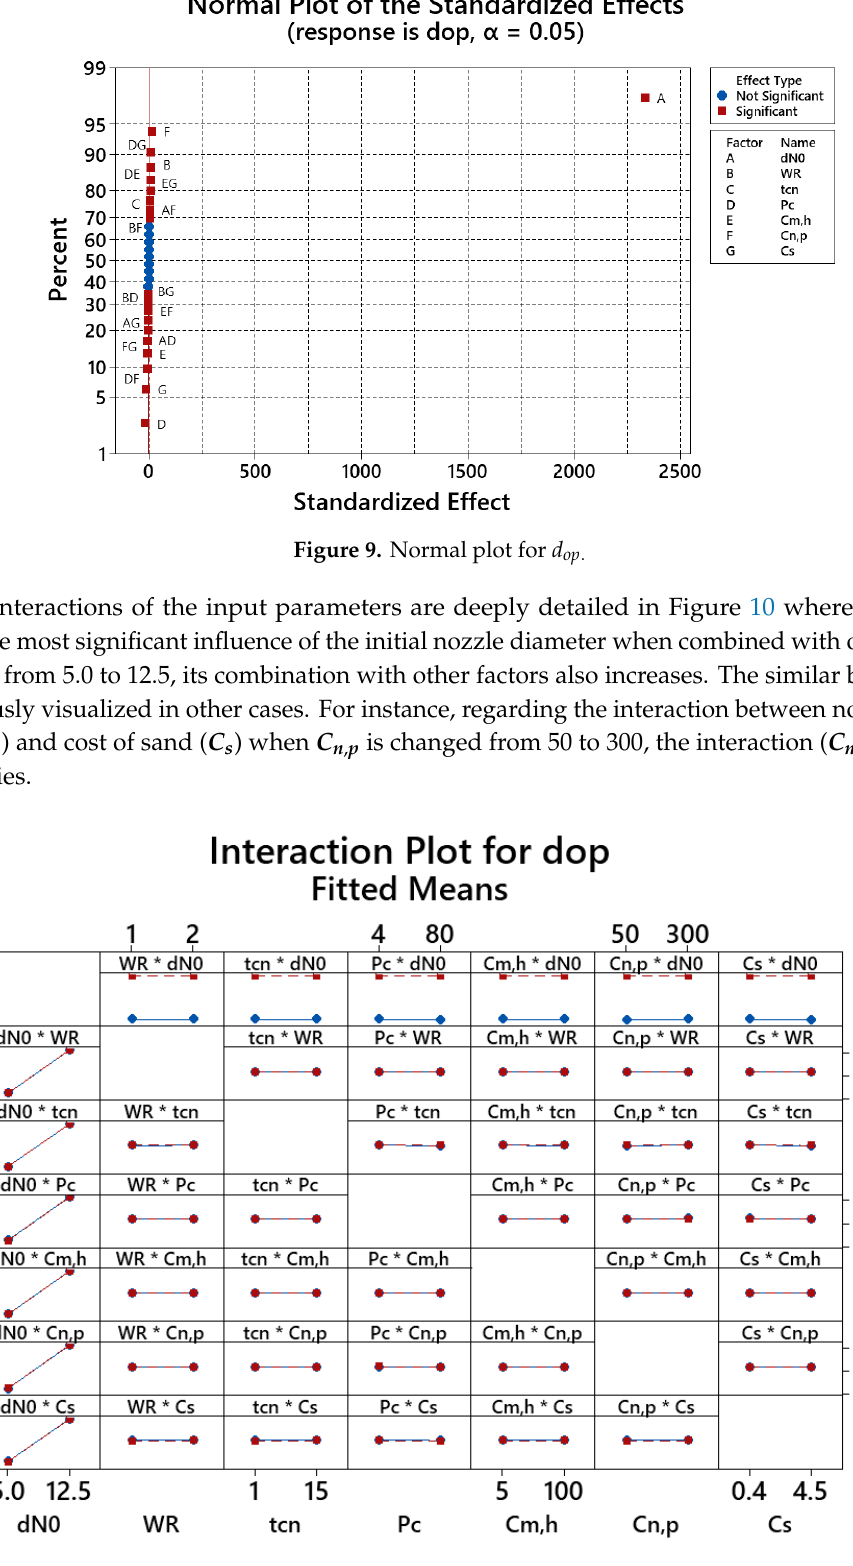
Figure 10. The interactions between input parameters.